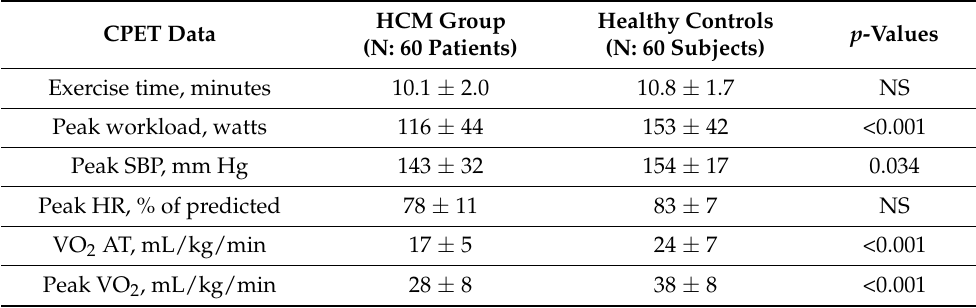
Figure 2. Comparison between peak oxygen uptake (pVO 2 ) values between healthy controls and HCM patients (column A ) and between HCM patients who did not experience (No Event Group) or experienced (Event Group) adverse events (column B ). *** p < 0.0001; ** p < 0.001. Table 2. Comparison between the main cardiopulmonary exercise test (CPET) variables between HCM group and healthy